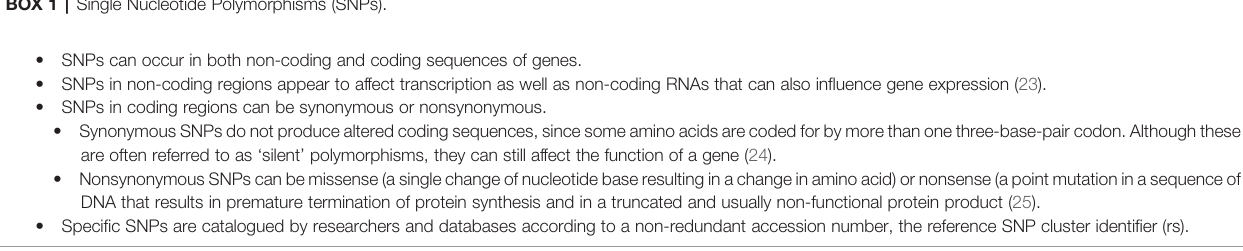
Amino acid Molecular characteristics: Homozygous vs substitution heterozygous states